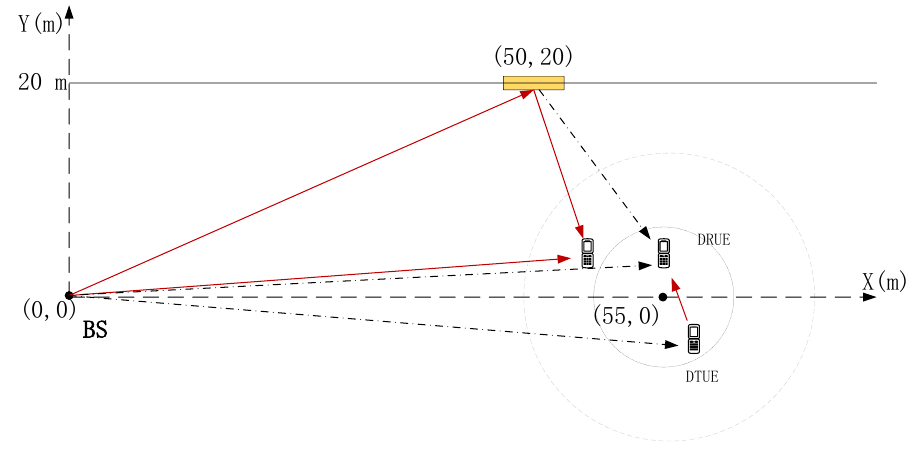
Figure 2. The simulated system setup.